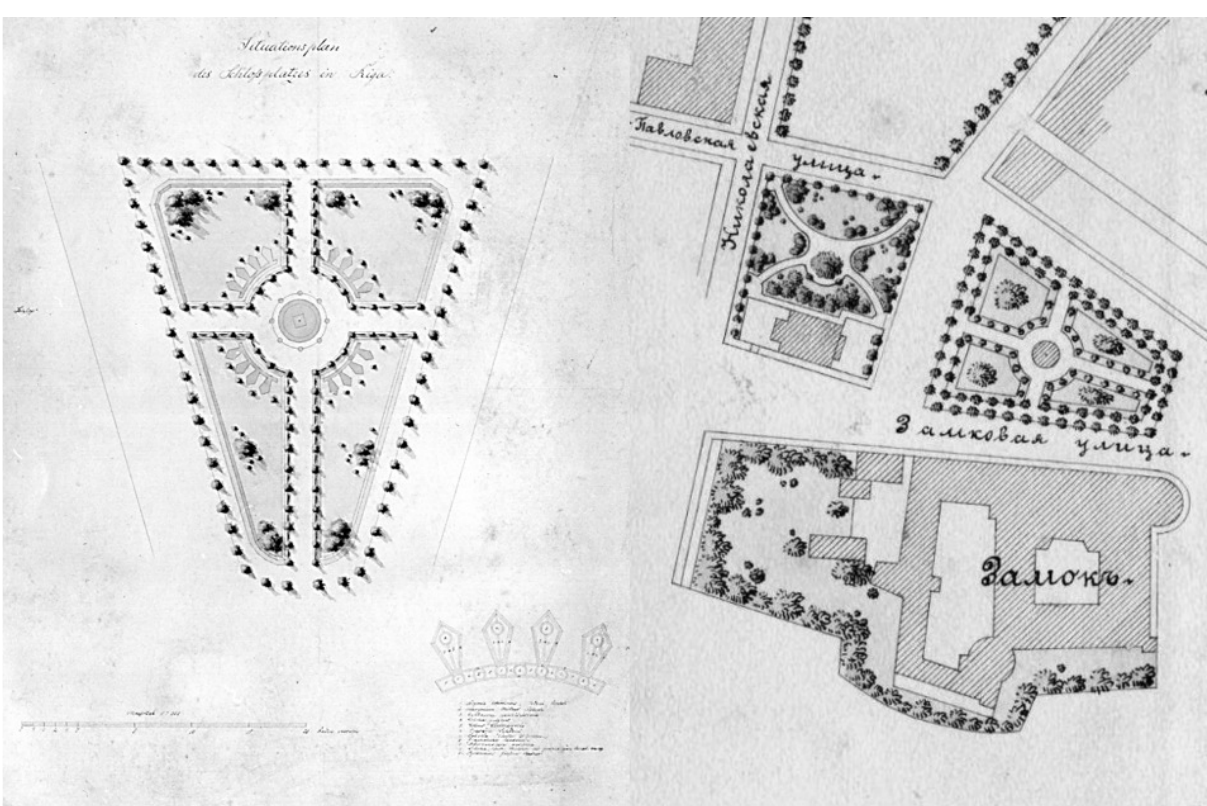
Figure 5. The central part of Castle Square laid out as a garden in the Dutch Baroque style: Plan of the Castle Square, signed by G. Kuphaldt, ca. 1881 (left) and 1902